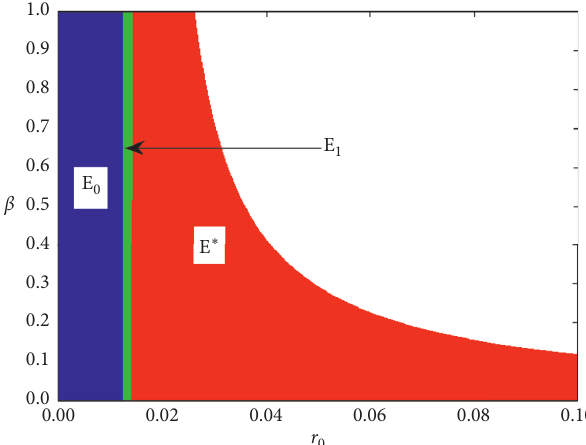
− β ) 0 � 0 . 05. In the 2 and the interior 1 and 0